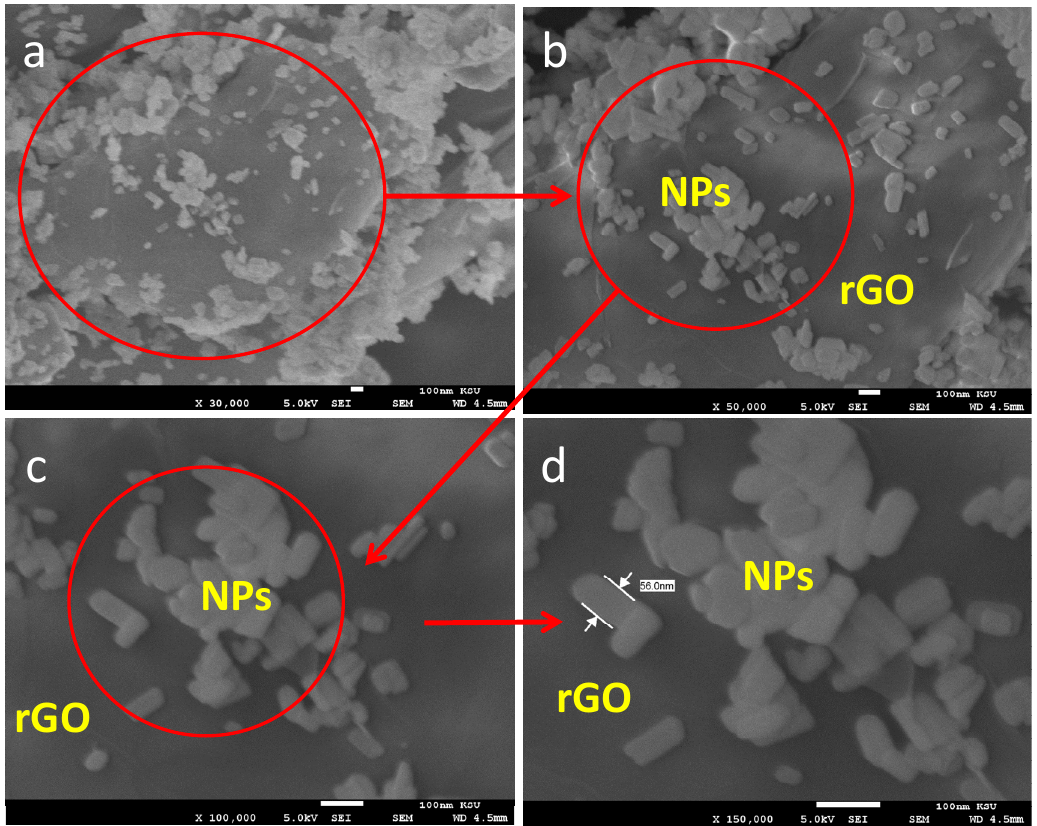
Figure 2. FESEM micrographs of ZnWO 4 -NPs@rGO nanocomposites at ( a , b ) low and ( c , d ) high magnifications.